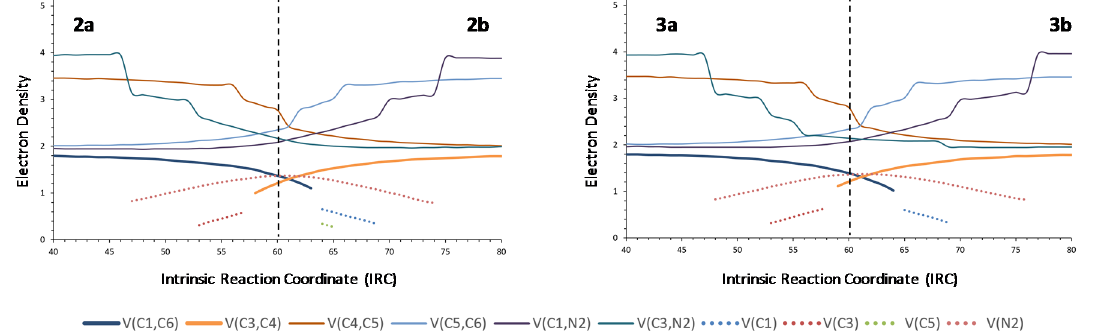
Figure 5. ELF analyses for the 2-aza-Cope rearrangement of nitrones 2 and 3 .